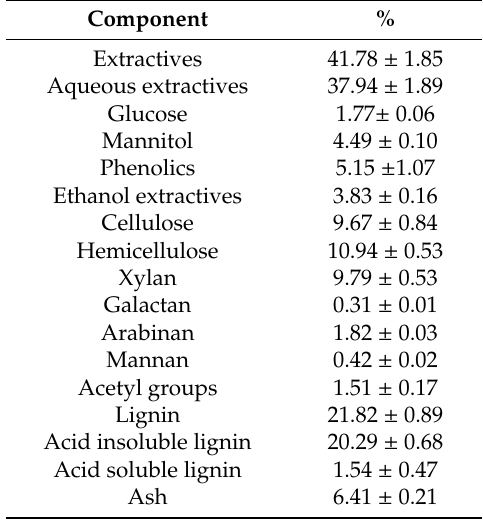
Table 1. Chemical composition of exhausted olive pomace